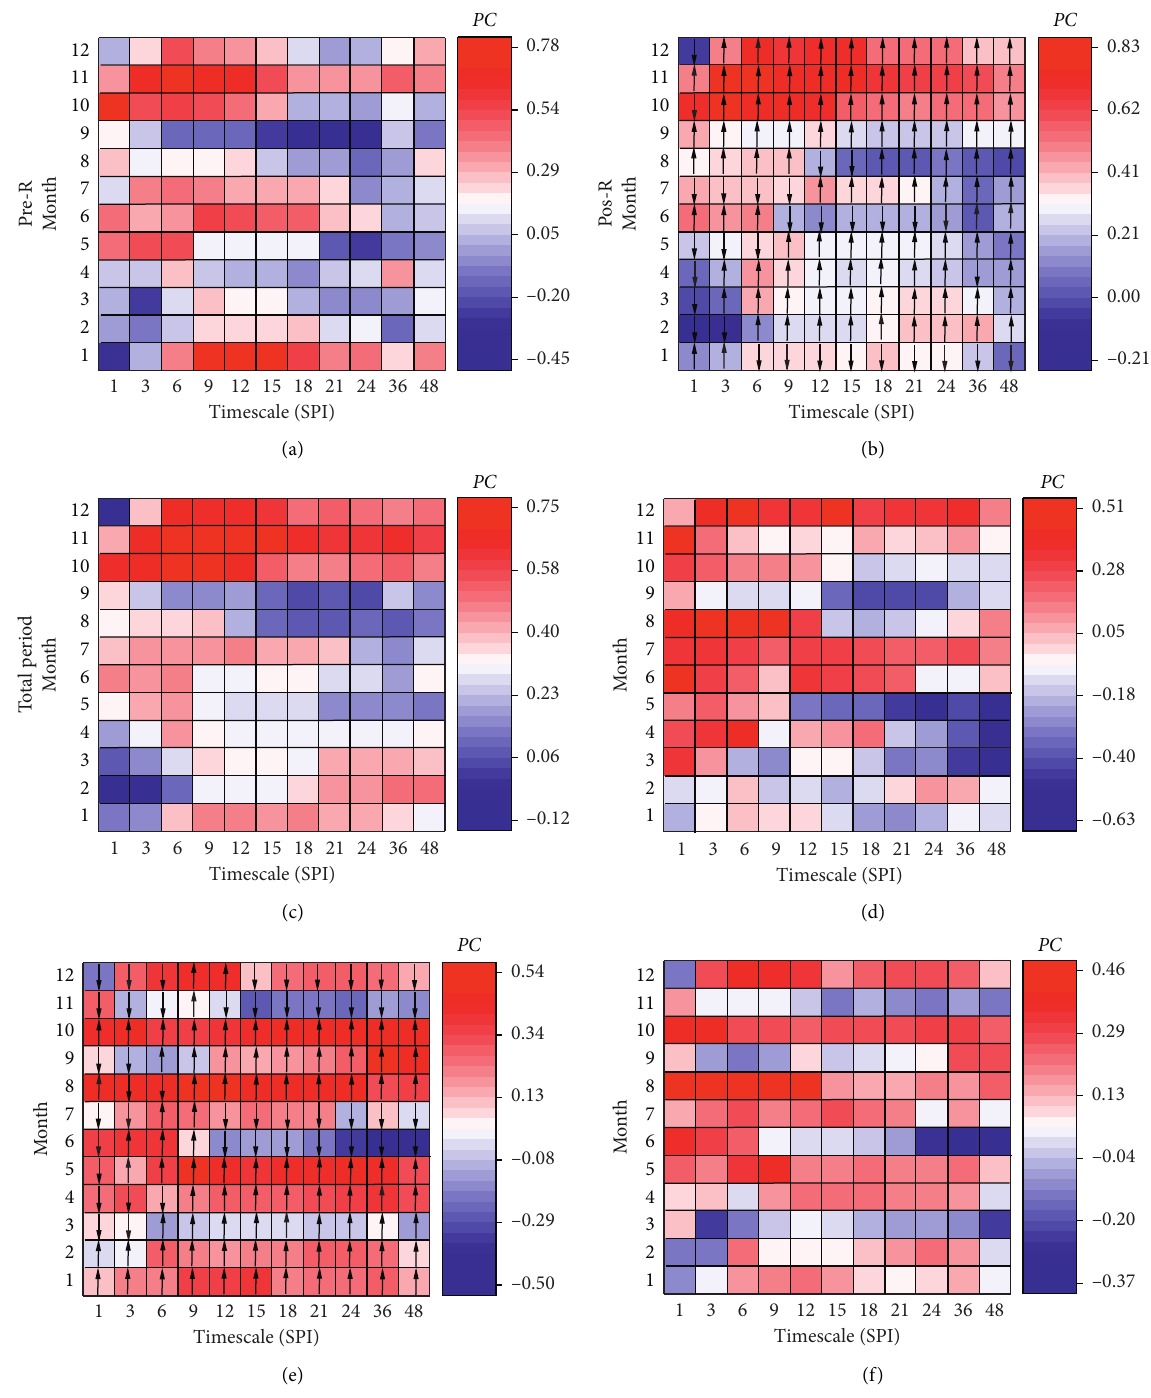
Figure 11: Heat map showing Intra-annual PC of SPI accumulation periods of 1–48 months with SDI-1 in the UHRB (Ylx) and MHRB (Zyx) (note: the x-axis represents the correlation between the SDI-1 and SPI at different timescales and the y-axis represents the 12 months of the year; the up arrow represents the correlation coefficients that increased in the postreservoir period (Pos-R) in the Ylx and Zyx compared to the period of prereservoir (Pre-R), or vice versa); (a) (1965–1979, PC ≥ 0.52, p < 0.05), (b) (1980–2012, PC ≥ 0.35, p < 0.05), and (c) (1965–2012, PC ≥ 0.29, p < 0.05) in the UHRB (Ylx), and (d) (1965–1984, PC ≥ 0.45 or ≤ − 0.47, p < 0.05), (e) (1985–2012, PC ≥ 0.38 or ≤ − 0.48, p < 0.05), and (f) (1965–2012, PC ≥ 0.29 or ≤ − 0.33, p < 0.05) in the MHRB